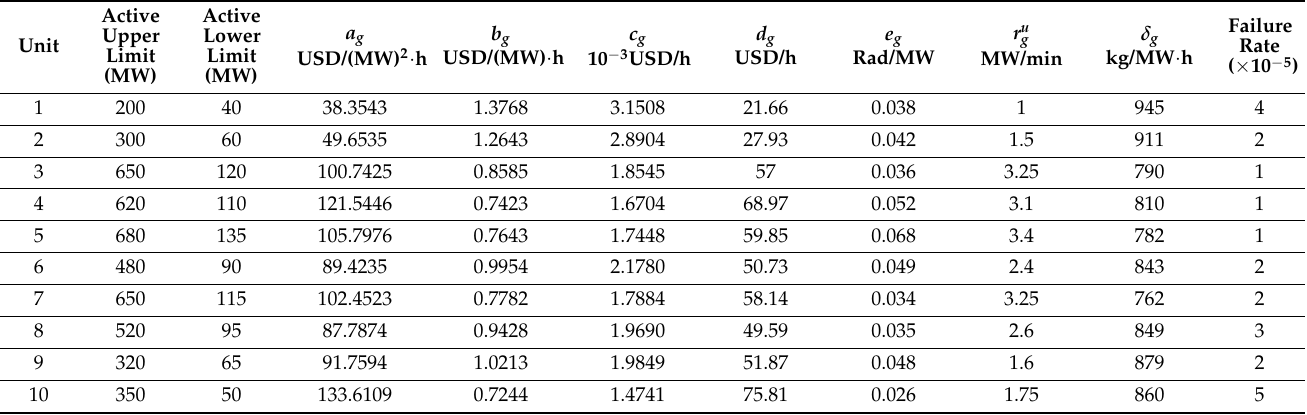
Table A1. Conventional generator